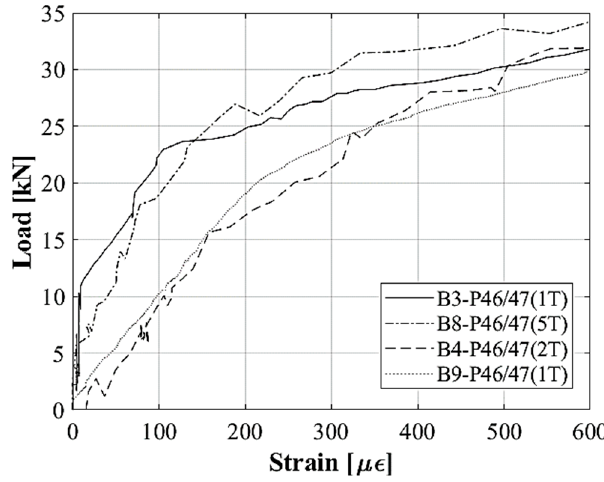
Figure 14. Applied load versus tensile strain.